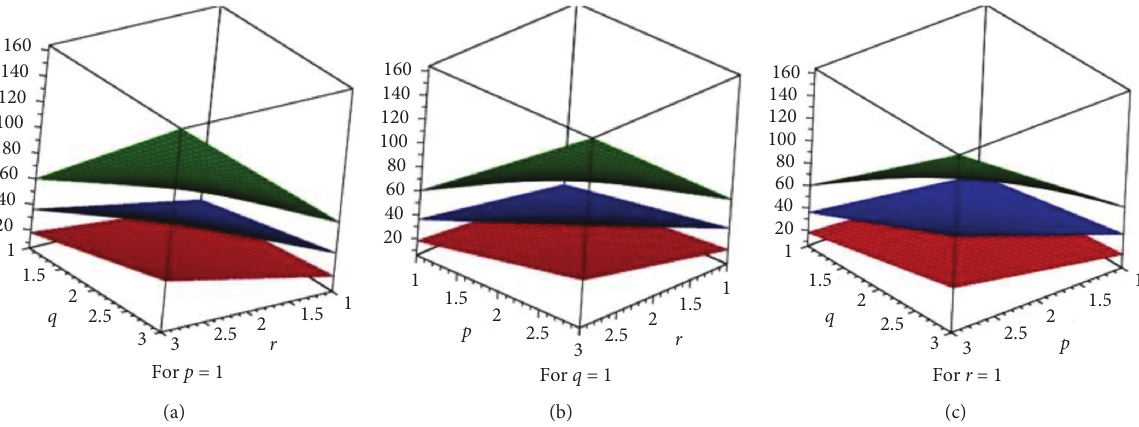
Figure 6: Comparison of IRR , IRR